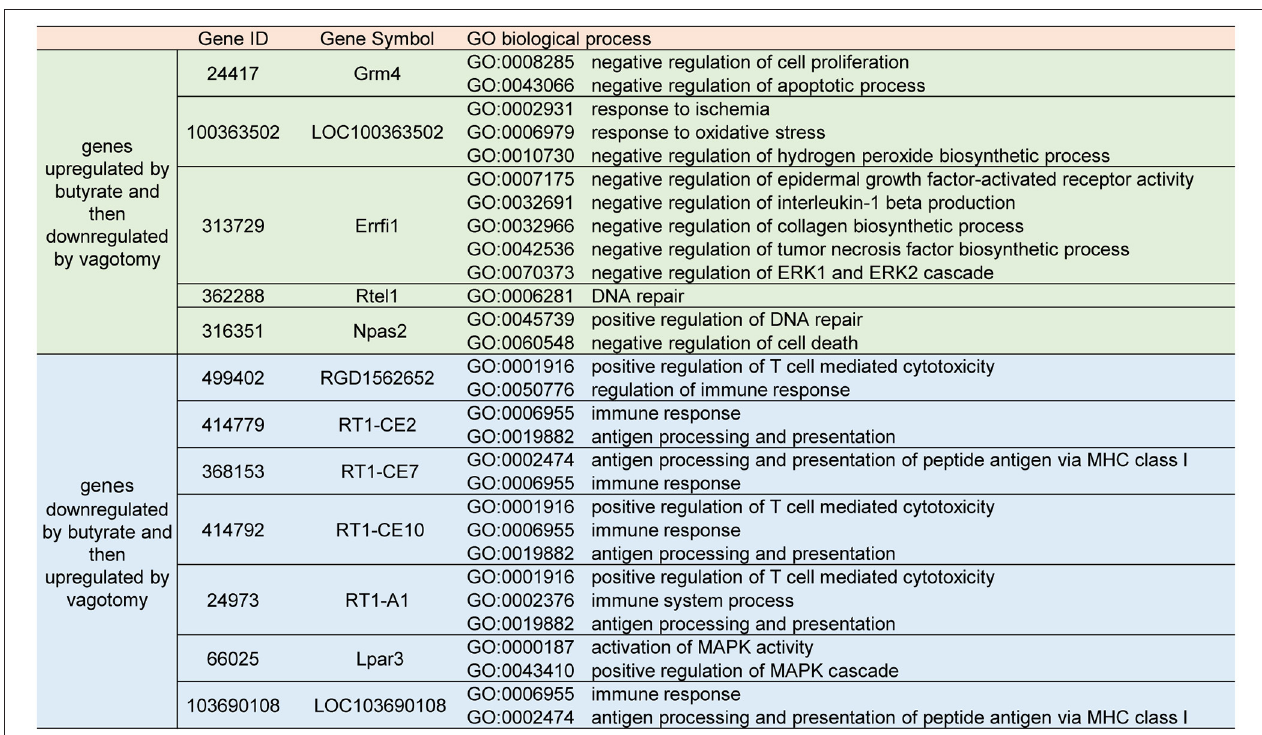
FIGURE 5 | Part of GO biological process annotations of butyrate altered genes reversed by vagotomy.